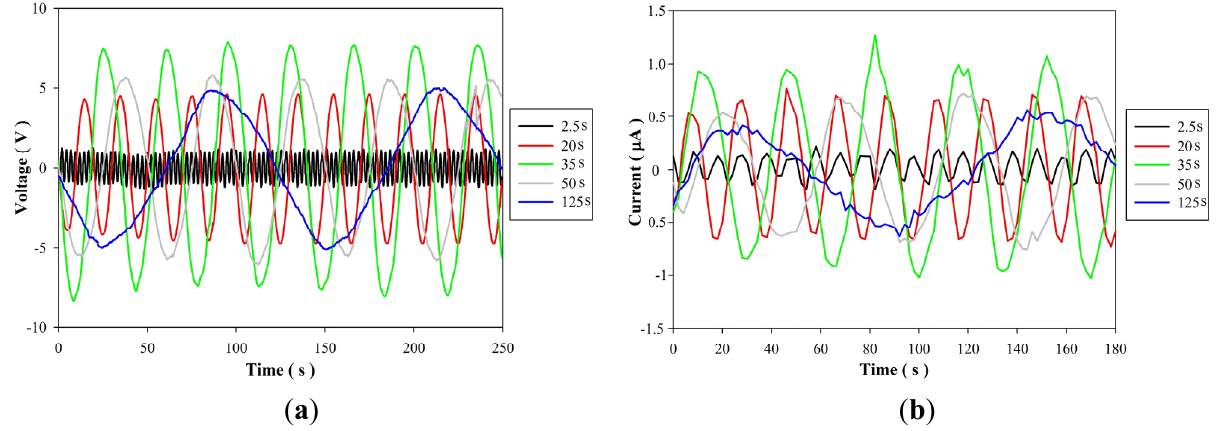
Figure 7. Relationships between the voltage ( a ) and current ( b ) at five different period times (2.5 s, 20 s, 35 s, 50 s and 125 s) for the PZT (Lead Zirconate Titanate) pyroelectric